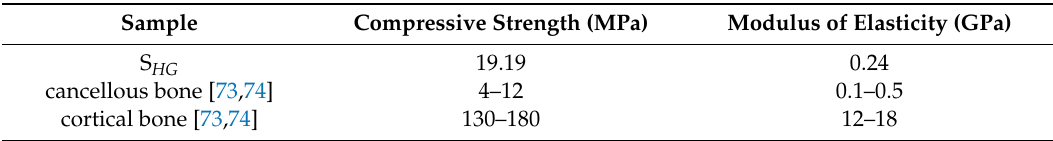
Table 1. Comparison between compressive strength and modulus of elasticity of S HG , cancellous bone and cortical